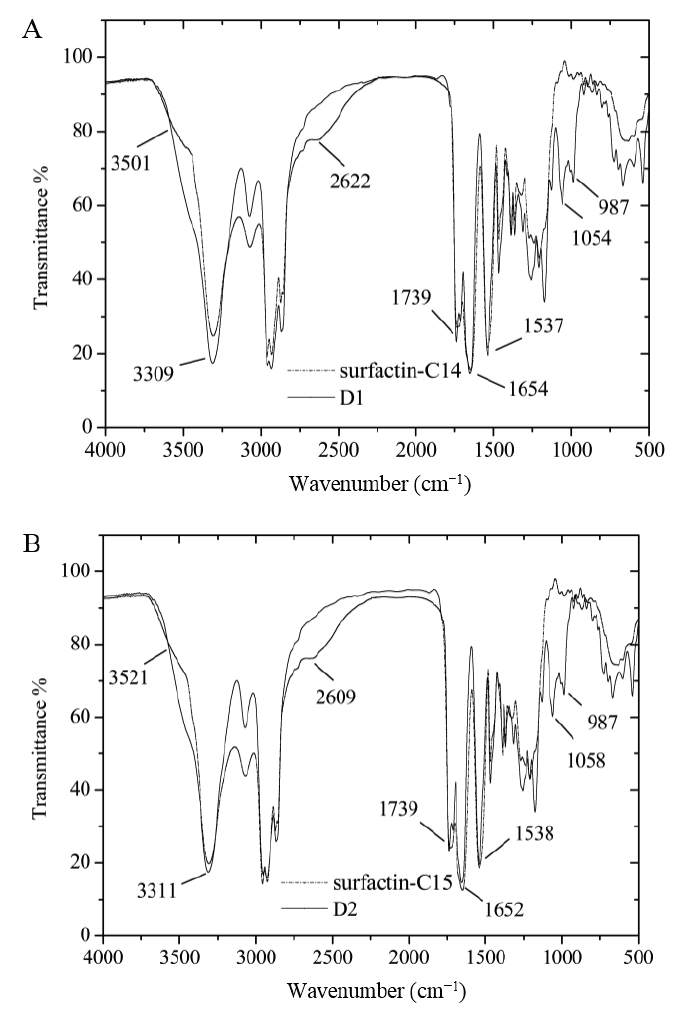
Figure 11. FT-IR results of surfactin-C14 and surfactin-C15, D1 and D2. ( A ) for surfactin-C14 and di -6-hydoxyl-hexyl-surfactin C14 ester; and ( B ) for surfactin-C15 and di -6-hydoxyl-hexyl-surfactin C15